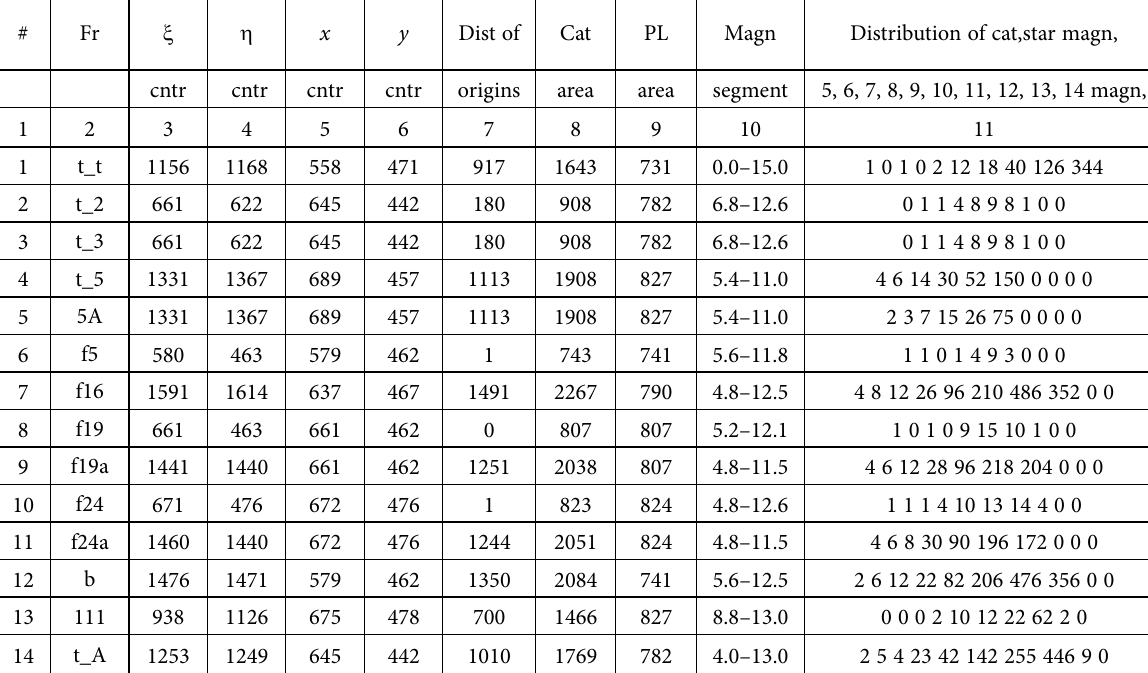
Table 3. Star set placements and the chosen catalogue star